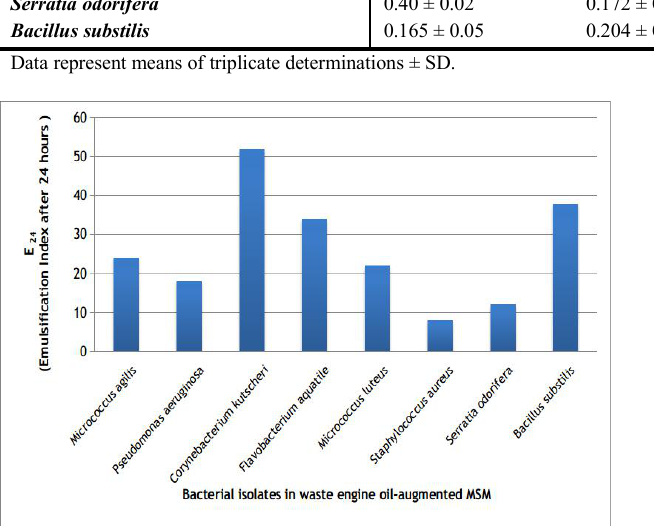
Figure 1 : Emulsification activity (E24) of bacterial